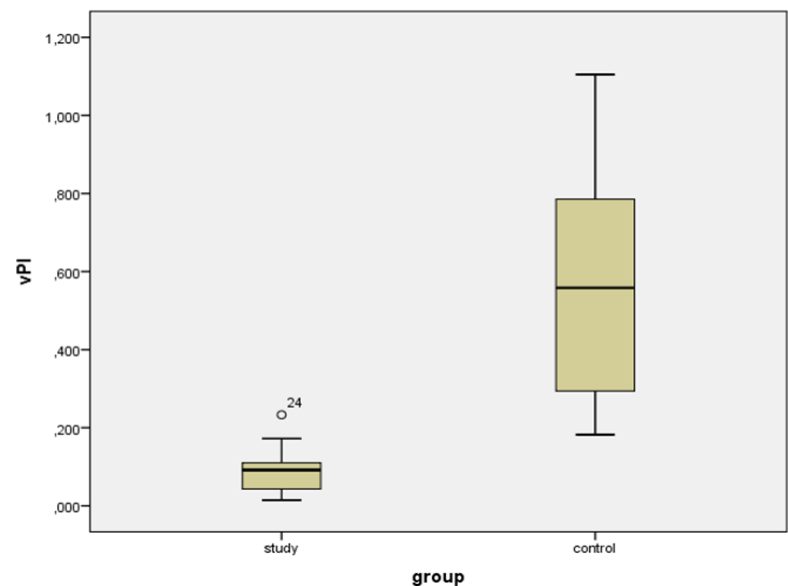
Figure 7. Box-plot for volumetric (4D) Systolic/Diastolic (vS/D) Index for study and control group.